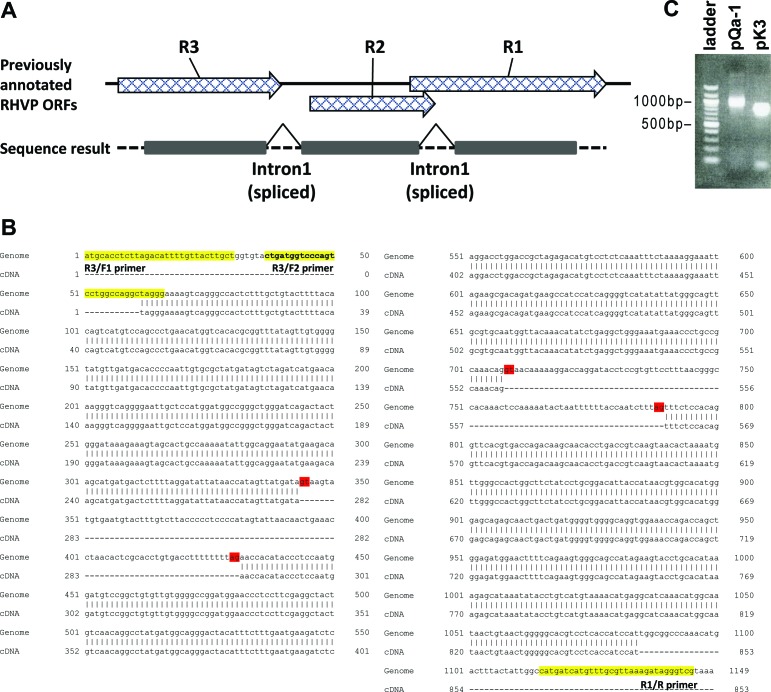
Three previously annotated RHVP ORFs are spliced to form mRNA encoding an MHC-I-like protein.(A) Schematic depiction of RHVP ORFs and the RNA splicing events. The genomic sequence is represented by a dotted black line. Previously annotated ORFs are represented by pattern-filled block arrows. The translated regions in the RHVP genome verified by RT-PCR and DNA sequencing are represented by black blocks. (B) Nucleotide alignment of the sequencing result to the viral genome. Total RNA was prepared from RHVP-infected IFNαβγR-/- mouse embryonic fibroblasts 24 hr post-infection, from which a first strand cDNA pool was obtained by RT-PCR using oligo dT. The DNA sequences amplified by PCR from the cDNA pool (using primers highlighted in yellow) were aligned with the viral genomic sequence of R1-R3 in reverse direction using EMBOSS Needle. The splice donor and acceptor site borders are highlighted in red and are reminiscent of the consensus splice sites in mammals. (C) Agarose gel image showing the PCR amplicons of the cDNA obtained from RHVP-infected MEFs using primers specific to pQa-1 and pK3. The following primers were used: RHVP-R3/F1 5'-atgcacctcttagacattttgttacttgct; RHVP-R3/F2 5'-ctgatggtcccagtcctggccaggctaggg; RHVP-R1/R 5'-cgaccctatctttaacgcaaacatgatcatg; RHVP-R12 (pK3)/F 5'-atggctttgcaggaggctg; PHVP-R12 (pK3)/R 5'-tataaacaaactgtcctactgc.